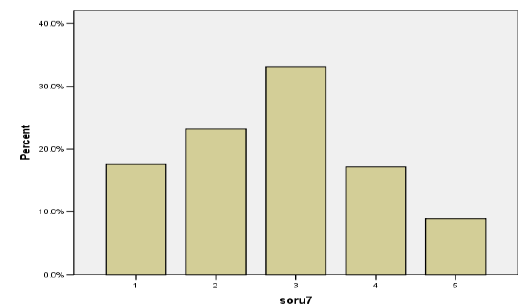
Figure 9. Are students taught in detail about TAS and Turkish auditing standards through their education? Q14: Do Financial (General) Accounting courses in